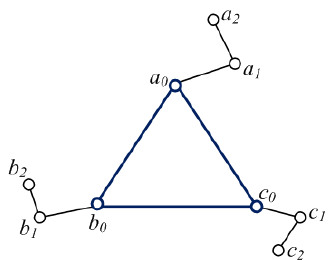
Figure 2. The triangular parametric domain of a cubic B-patch